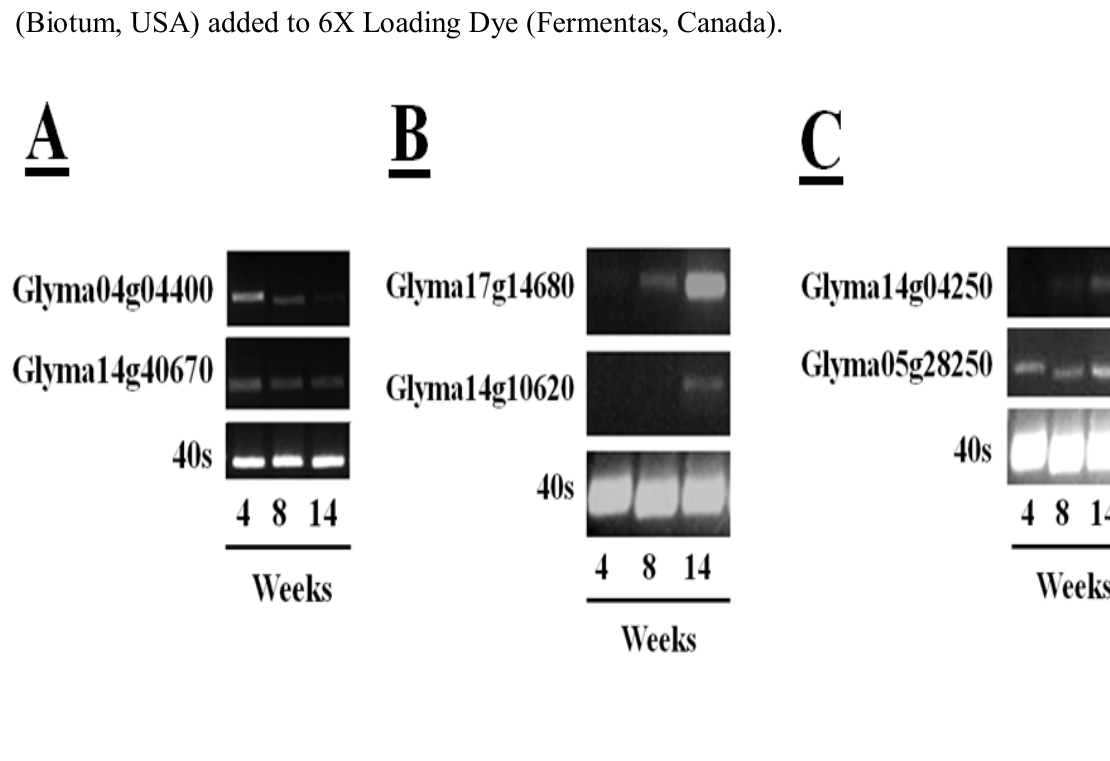
Figure 6. Transcription profiles of five papain-like cysteine proteases in soybean tissues of plants (cultivar Prima 2000) of different age (4, 8, and 14 weeks) determined by semi-quantitative RT-PCR. Amplification of the 40S gene sequence was used as a control. Semi-quantitative real-time polymerase chain reactions (semi-qRTPCR) were performed using 200 ng cDNA . For the reaction, 1 µL of the synthesized cDNA was used in a PCR reaction containing 2 µL of 10× PCR buffer, 1.6 µL of 25 mM MgCl , 2 µL of 2 mM 2 deoxyribonucleotide triphosphates (dNTPs), 0.4 µL of primers (10 µM), 0.2 µL of five units Taq polymerase. DNA amplification was done in a thermal cycler (Bio-Rad, USA) with denaturing DNA at 94 °C for 5 min followed by 25 to 46 cycles depending on the amplification product consisting of 94 °C for 30 s, 55 °C for 30 s for DNA annealing and 72 °C for 1 min for DNA extension. Final DNA elongation at 72 °C for 10 min. PCR samples were run on a 2% (w/v) agarose gel and DNA was stained with GelRed™ (Biotum, USA) added to 6X Loading Dye (Fermentas,